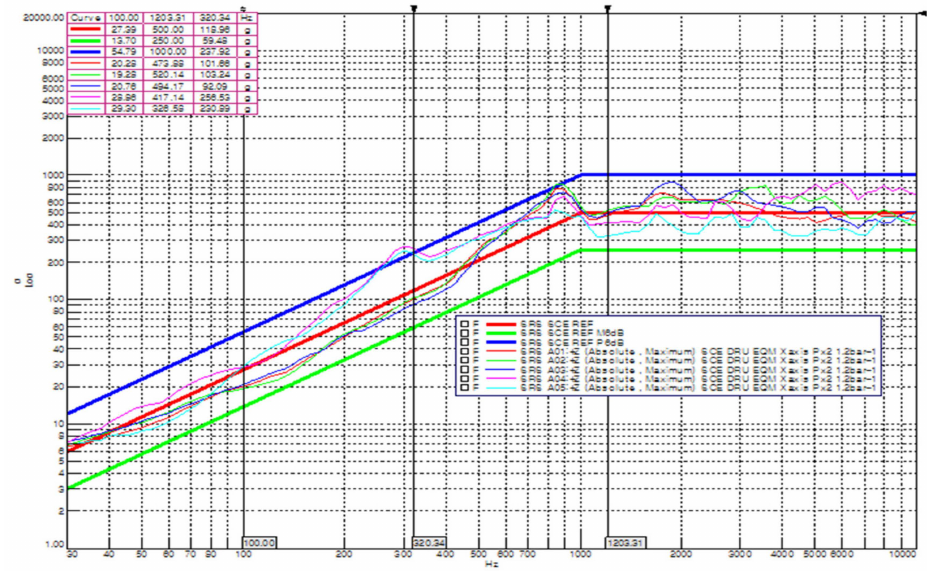
Figure 20. x -axis shock test results of